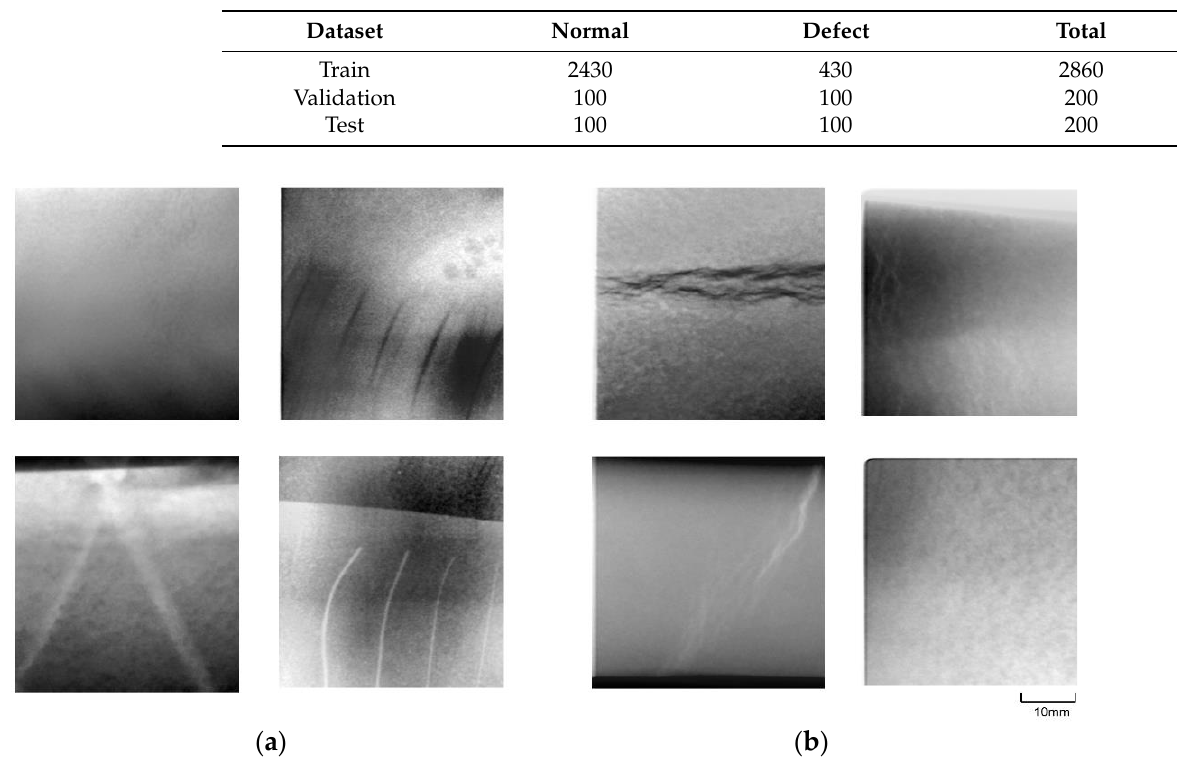
Table 1. The number of samples in this dataset.